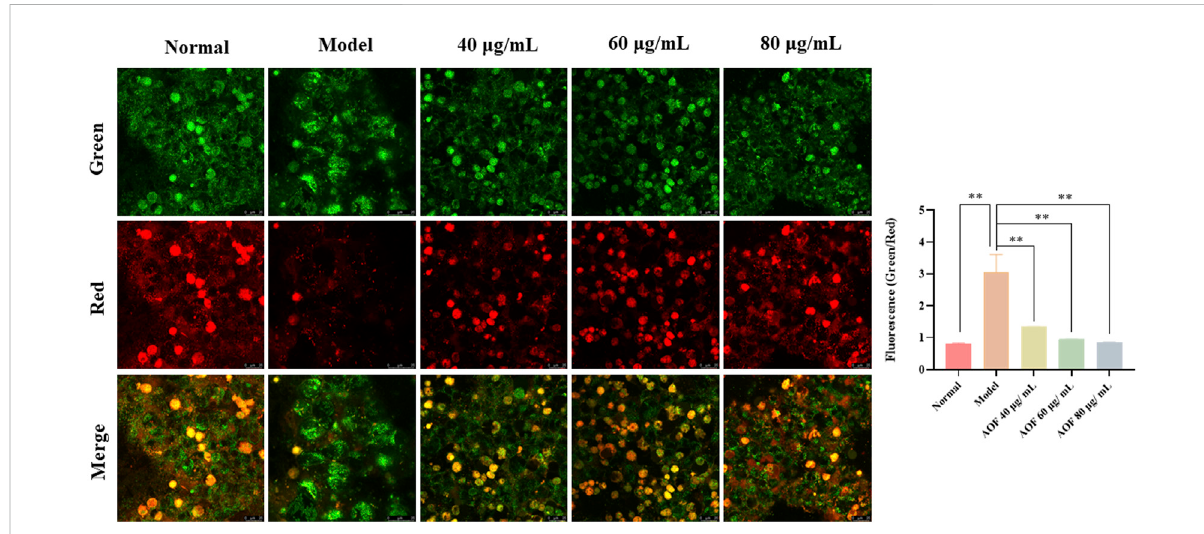
FIGURE 8 Effects of AOF on the ΔΨ m in H 2 O 2 -stimulated PC12 cells (×40). ΔΨ m was measured using aJC-1 assay kit and observed using alaser confocal microscopy. When mitochondrial function is normal, the MMP is at a higher potential, and JC-1 can form a polymer that aggregate in the mitochondrial matrix and emit red fl uorescence. However, when it is at the depolarized membrane potential, JC-1 could only exist in the cytoplasm as a monomer and emit green fl uorescence. Data were expressed as the mean ± SD ( n = 3). ** p < 0.01 vs model